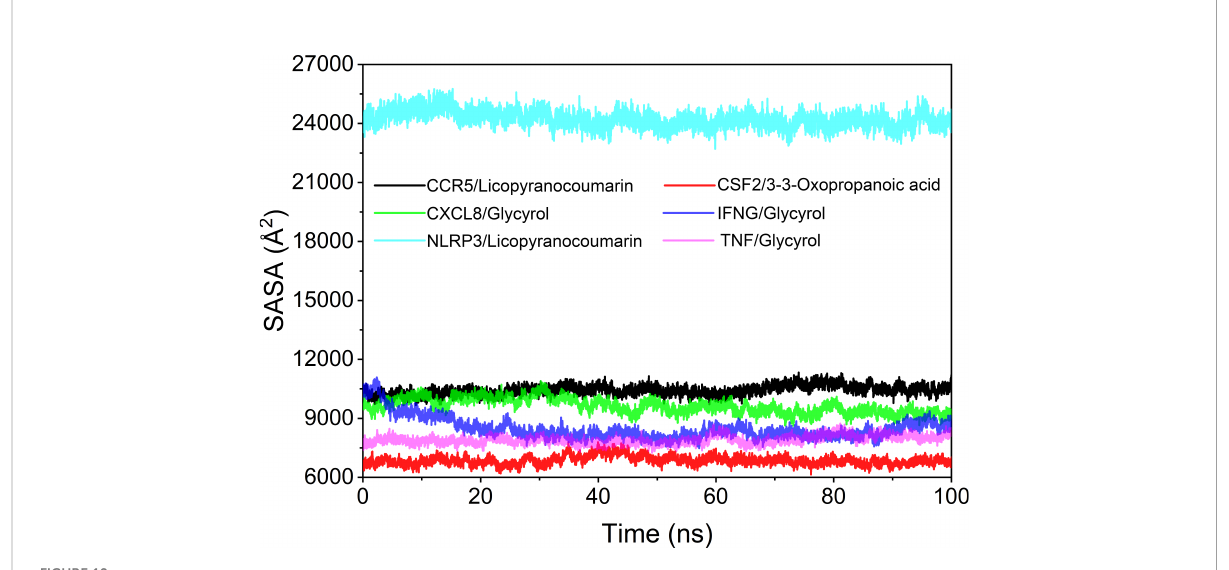
FIGURE 10 Analysis of solvent accessible surface area